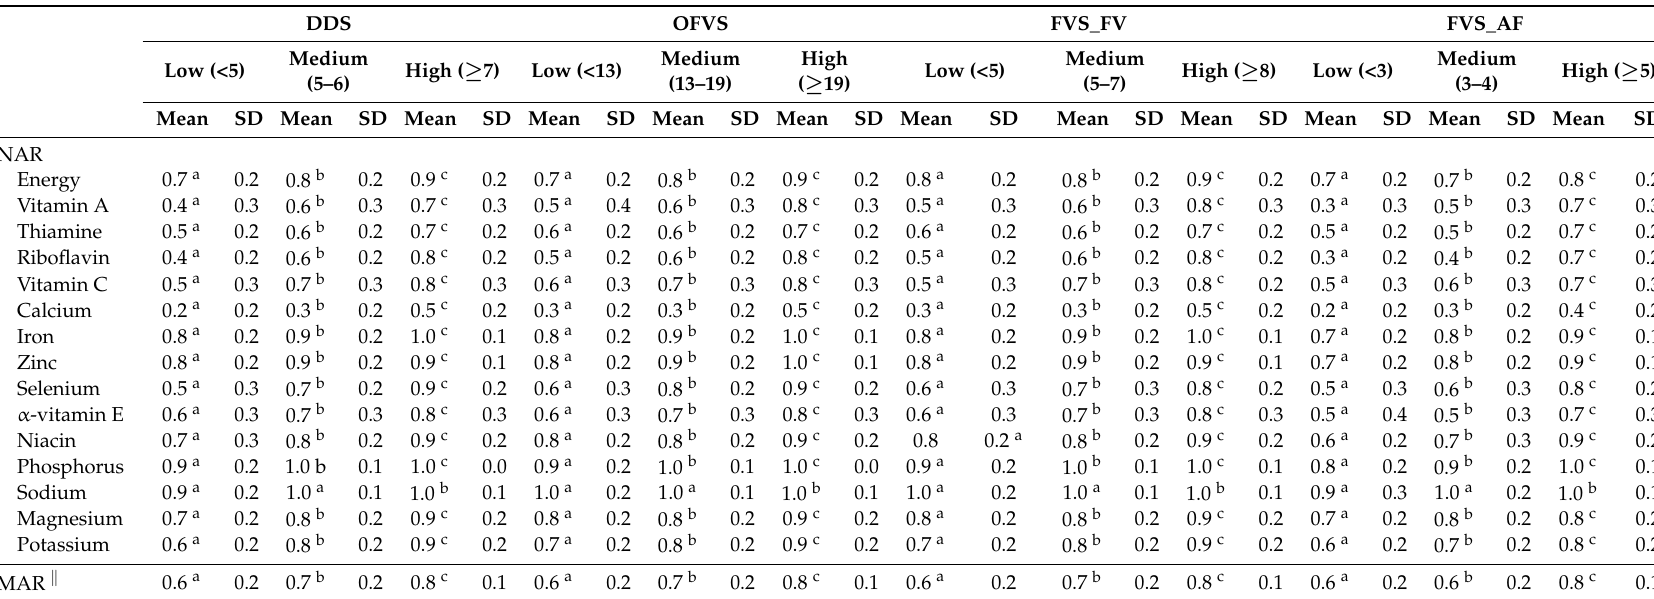
Table 2. NAR of nutrients and MAR among children in low, medium and high category of DDS and three FVSs ‡ ( n =